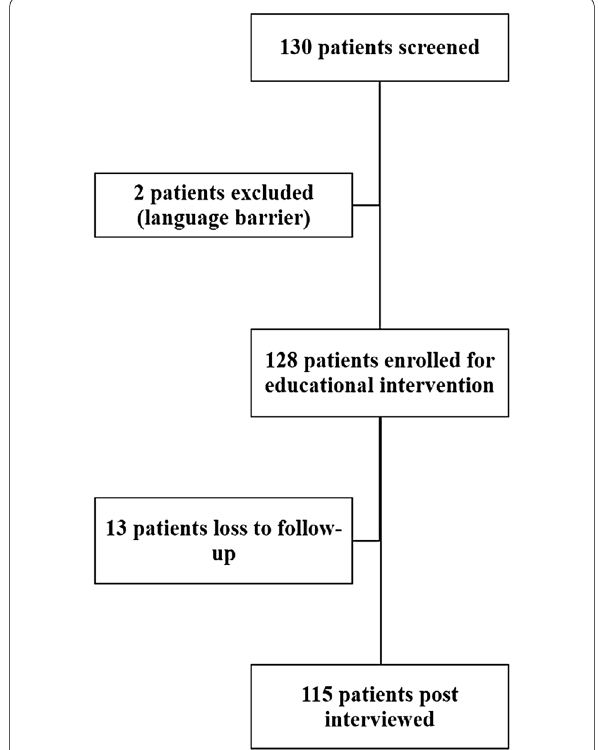
Fig. 2 Patient selection flow chart